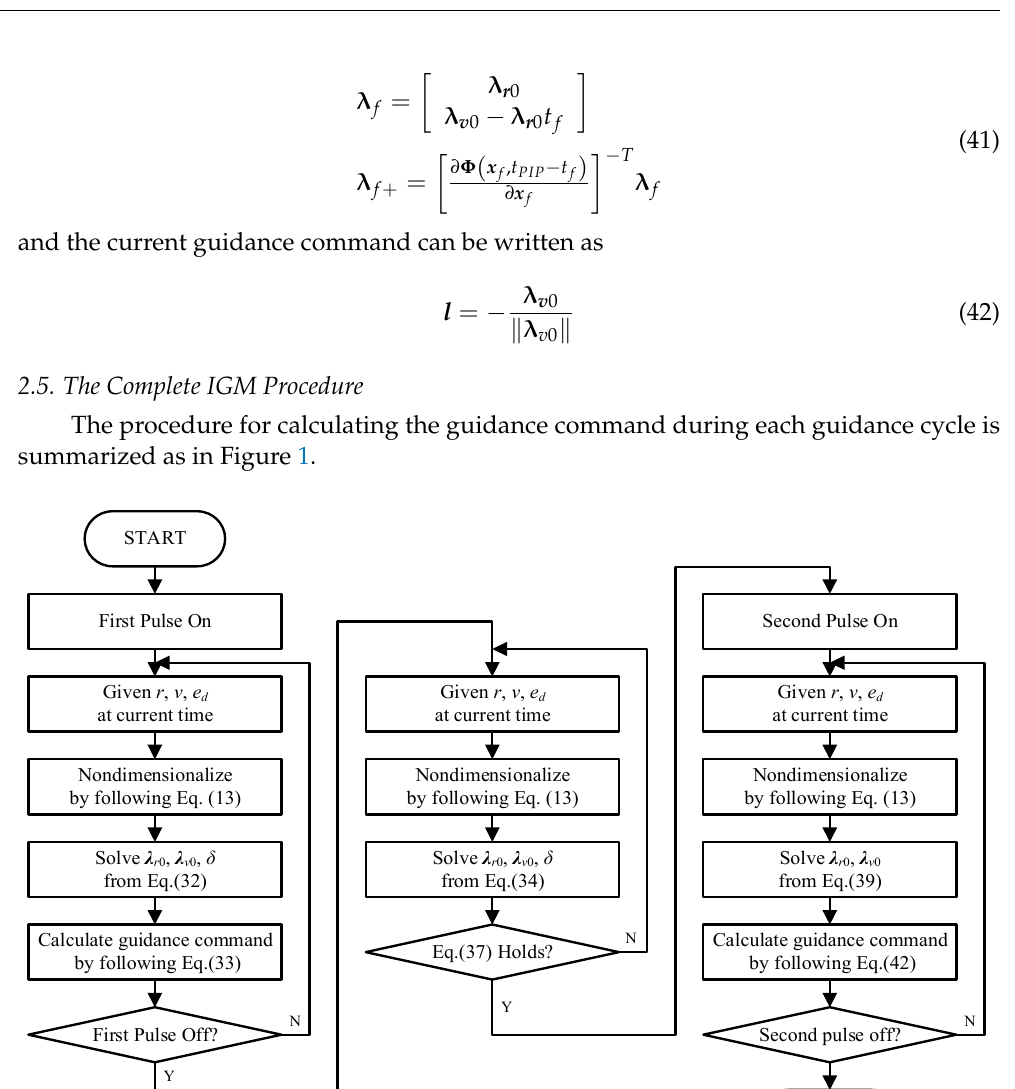
Table 1. Initial conditions of engagement.